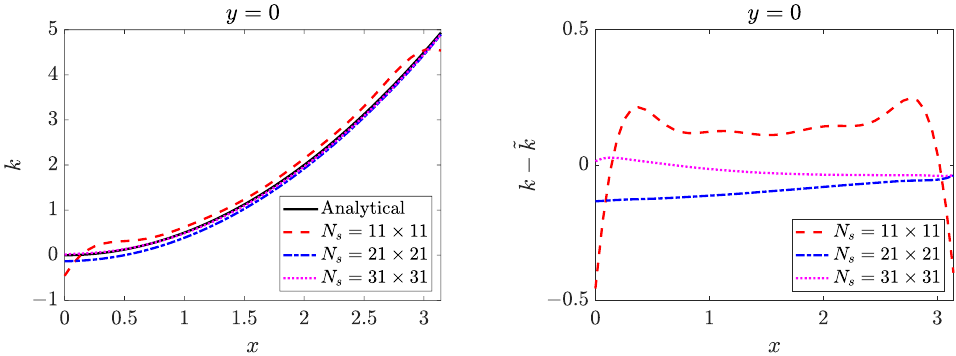
Figure 17. Solution and corresponding error of wave number k for the 2D varying parameter identification problem.